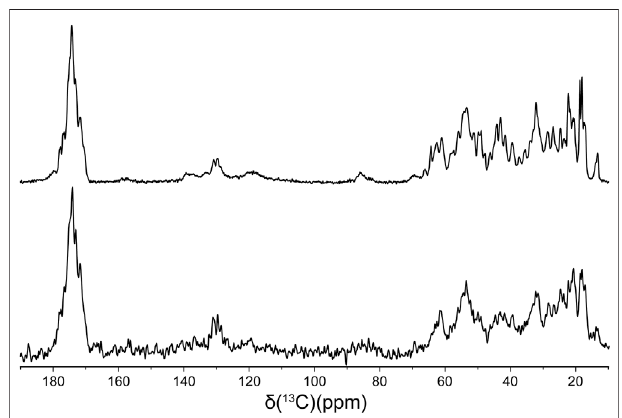
FIGURE 4 | 13 C CP-MAS spectra of 13 C, 15 N WT (top) and natural abundance Δ 28-98 (bottom) huPrP23-144 amyloid fi